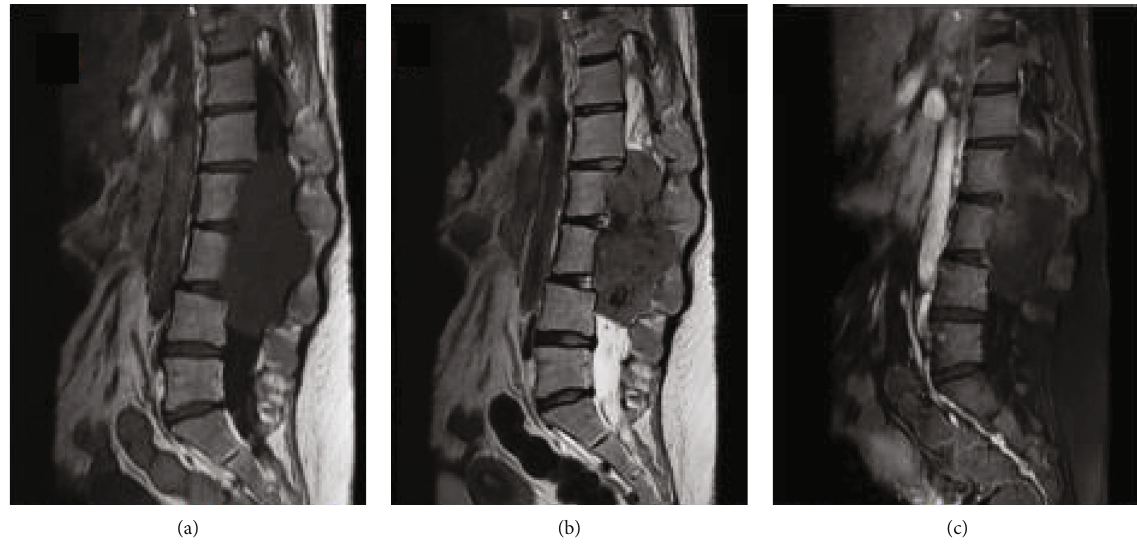
Figure 1: A lumbar spine MRI sagittal ((a) T1, (b) T2, and (c) T1 with contrast).